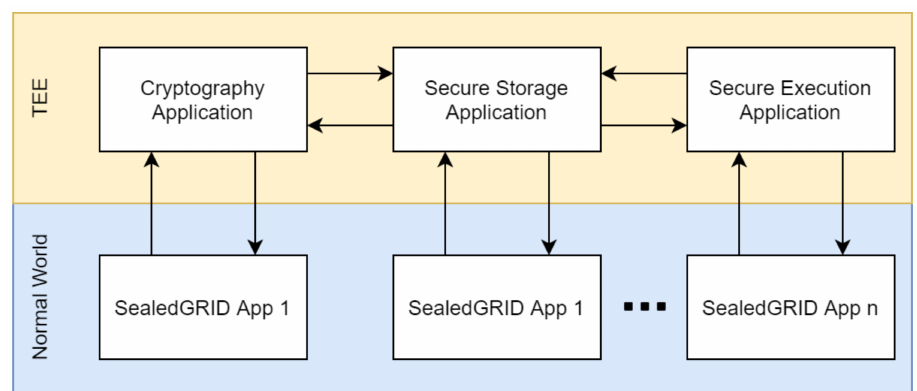
Figure 4. Component Overview of the TEE module.